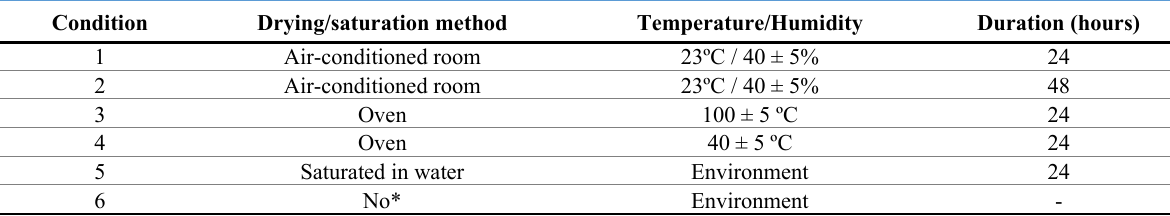
Table 1. Drying method and moisture condition of the blocks. Condition Drying/saturation method